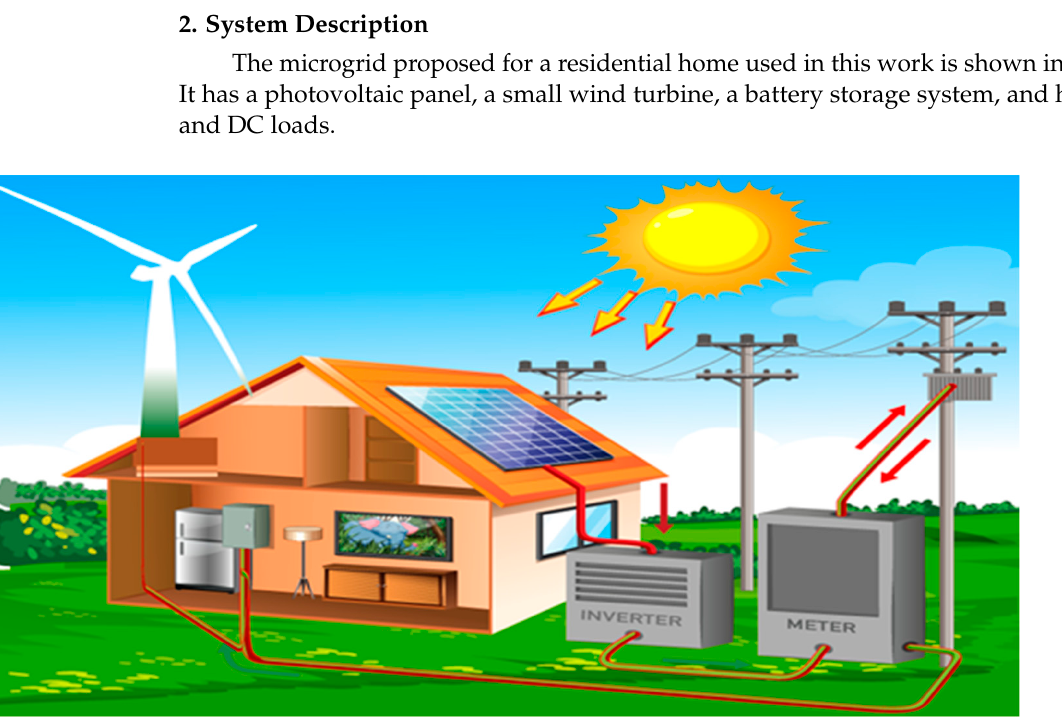
Figure 3. Proposed microgrid system for a residential home.